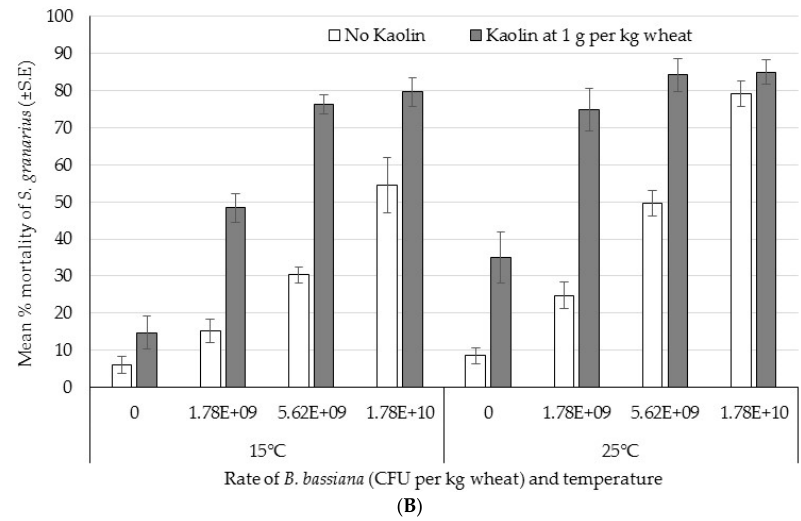
( B ) Figure 4. Bioassay 4: Percentage mortality of Sitophilus granarius exposed to different rates of Beauveria bassiana IMI389521 in colony forming units (CFU) per kg of wheat, with and without kaolin at 1 g per kg of wheat, at 15 or 25 °C after ( A ) 14 days and ( B ) 28 days of exposure (Mean ± SE). Not all of the data were a good fit for the probit model (Table 4), particularly if kaolin had been included in the treatment. At 14 days, including kaolin lowered the LC50 at both temperatures. At 28 days and 15 °C, the LC50 was also lowered when kaolin was included but no LC50 was calculated for the 25 °C data since all dose responses exceeded 50% mortality when kaolin was included. The LC50 at both time points was lower at 25 °C than at 15 °C. Table 4. Results of logistic regression on Sitophilus granarius adult mortality data for each treatment group (time × temp. × kaolin) in dose response bioassay 4.